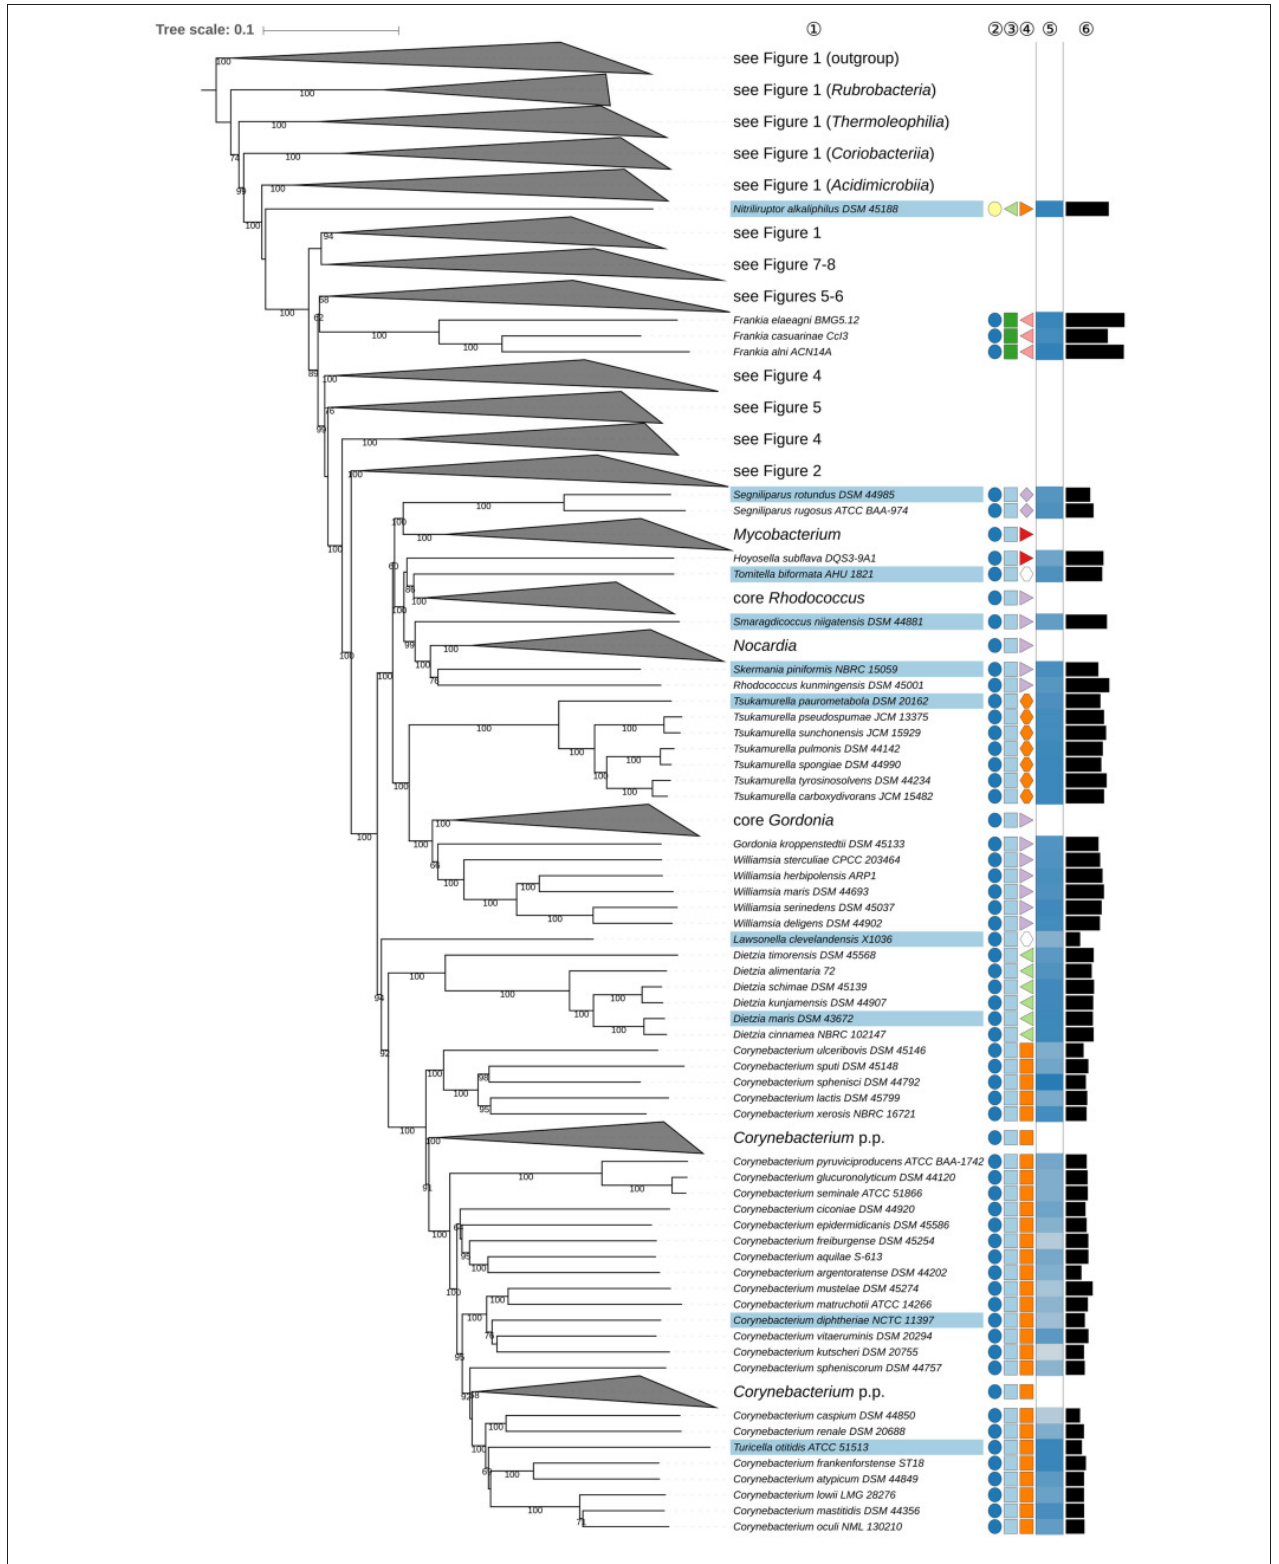
FIGURE 3 | Third part of the phylogenomic tree inferred with GBDP. A detailed description is provided in the caption of Figure 1 . The parts of the tree which have been collapsed here are shown in other figures as indicated.